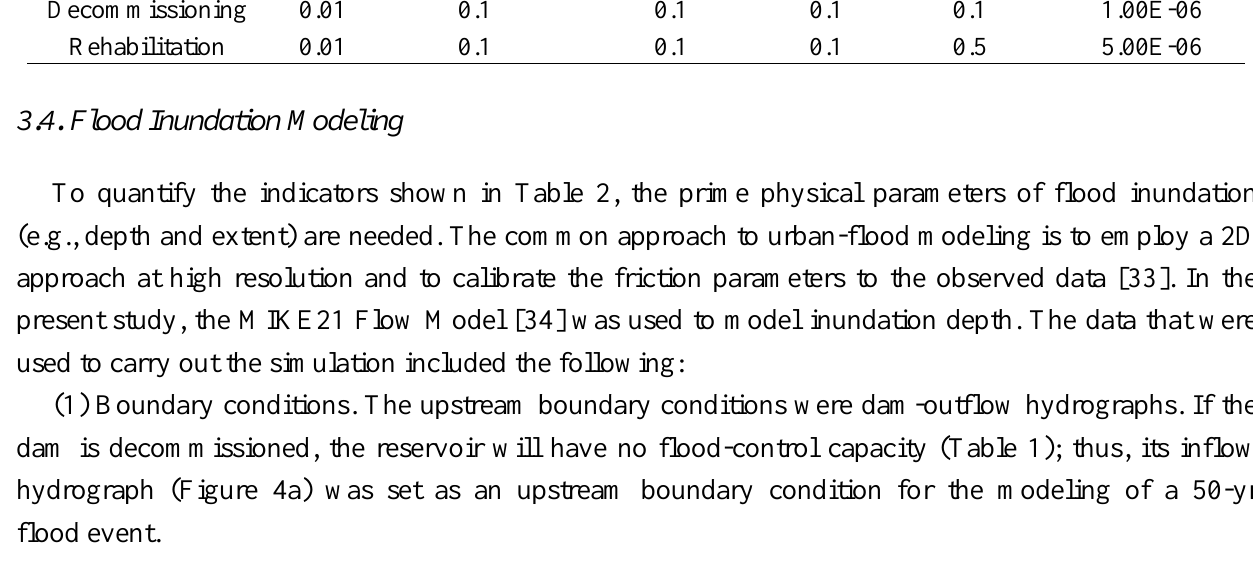
Figure 4. Upstream boundary conditions for inundation modeling of (a) 50-year flood events and (b) dam failure